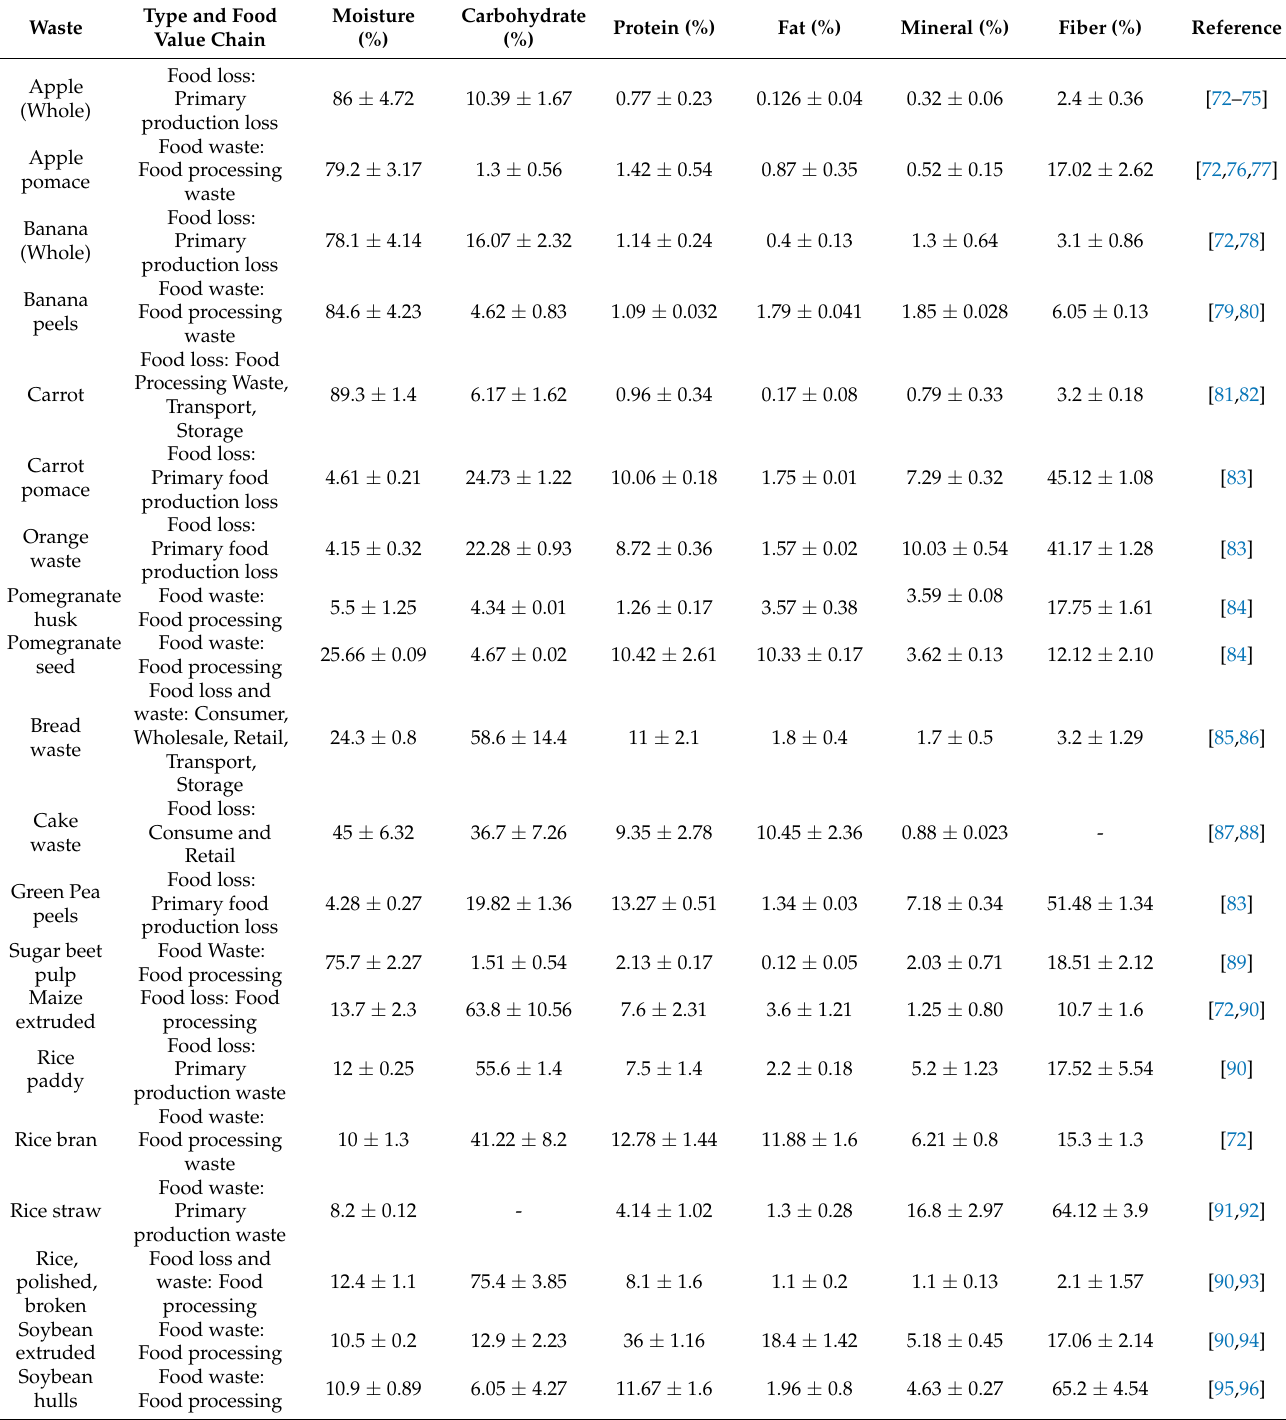
Table 1. The compositional profile of various waste products at different levels of food value chain (per 100